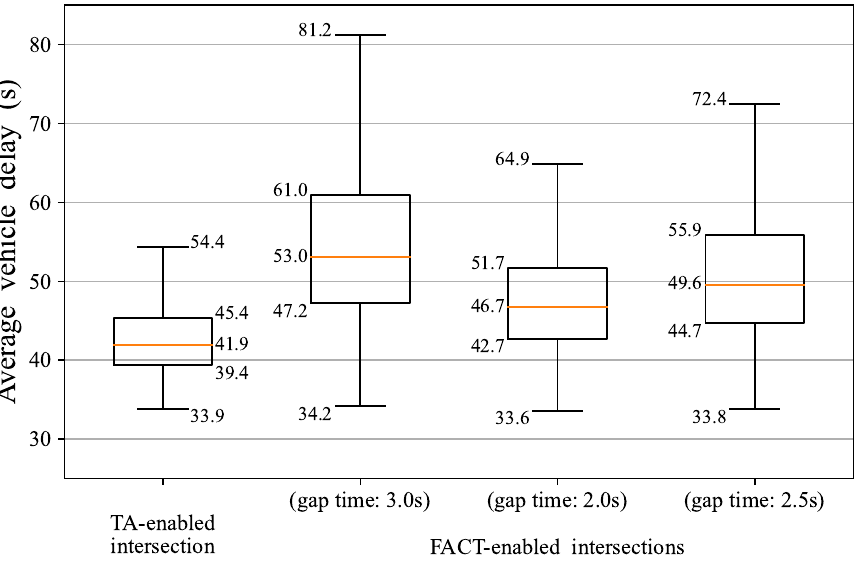
Figure 6. Box plots of the average vehicle delay at the TA-enabled and FACT-enabled intersections with different gap